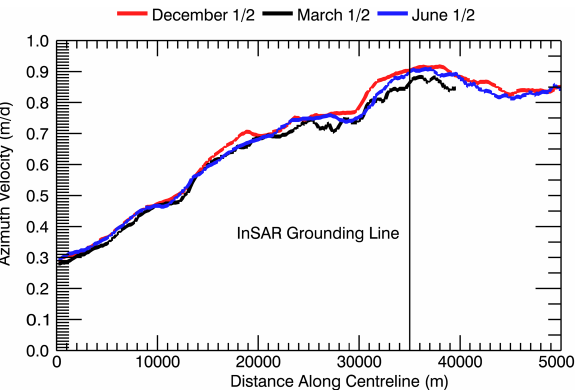
Fig. 6c. TerraSAR-X velocities in radar azimuth direction for De- cember 2010, March 2012 and June 2012. The location of the cen- treline is shown in Fig. 3 with the origin at the upstream edge of the